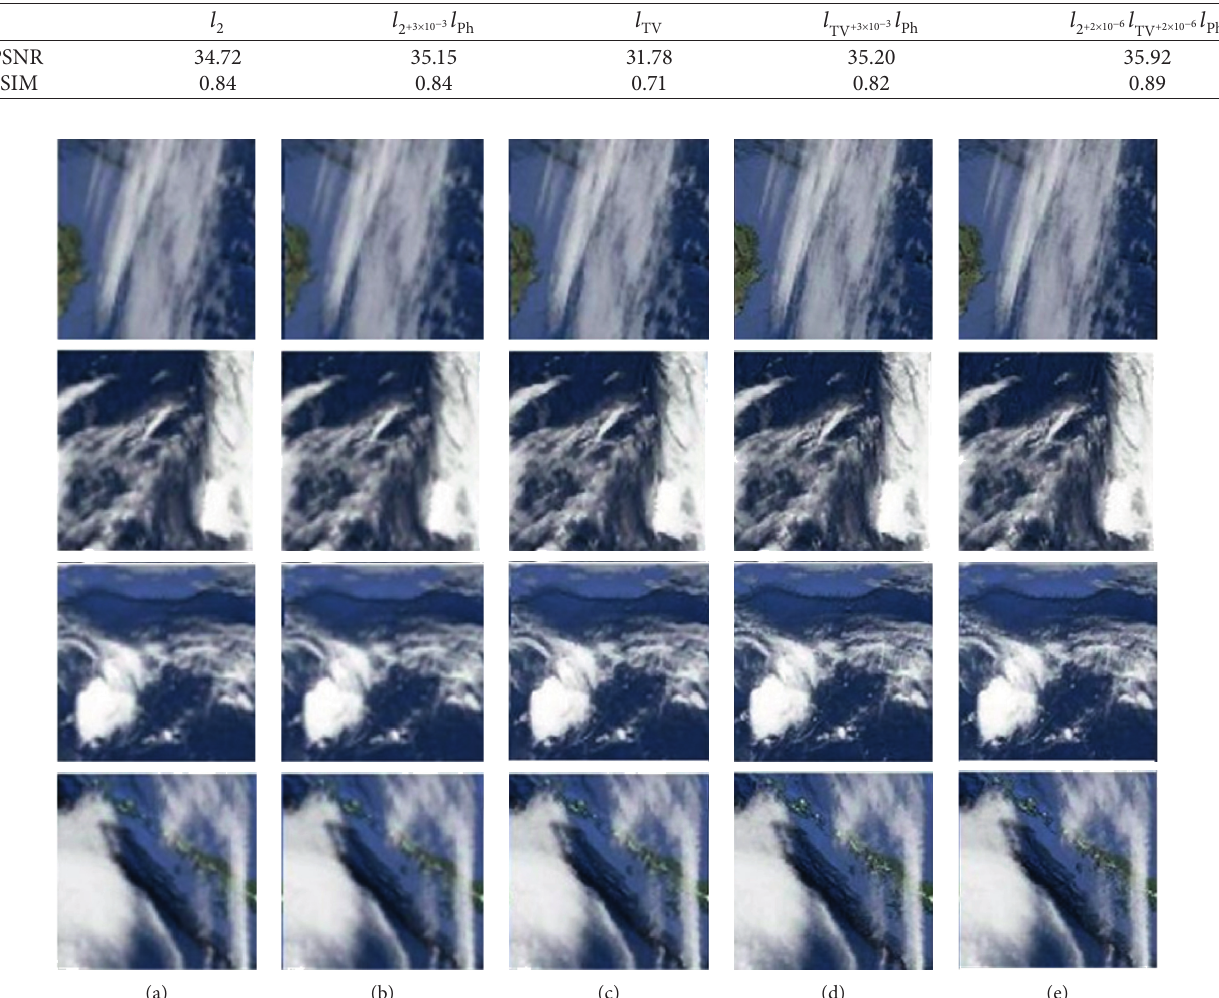
Table 1: Mean PSNR and SSIM of ablation experiment (500 testing images).